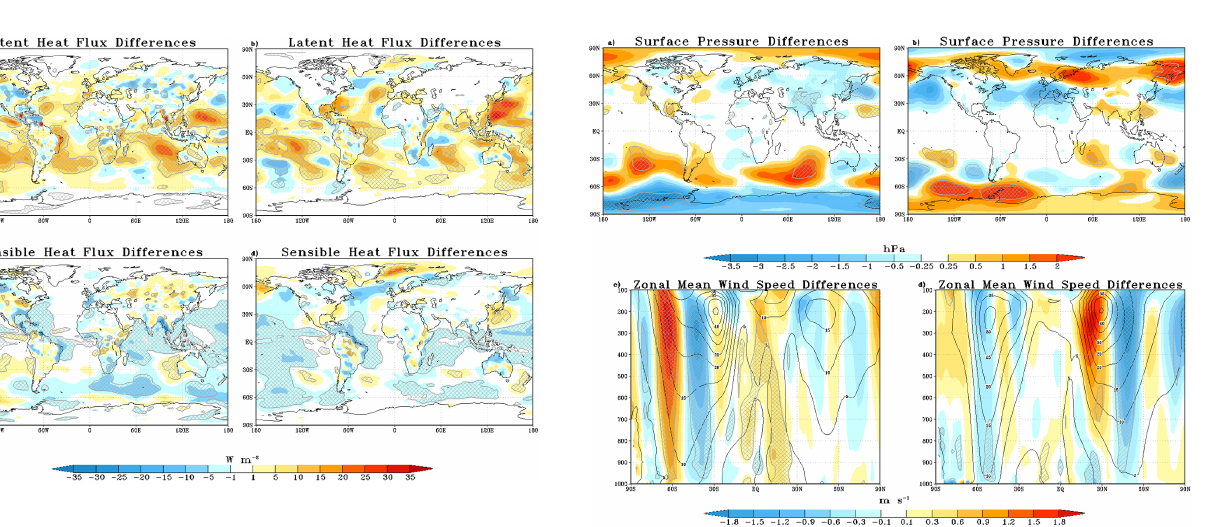
Figure 6. Seasonal mean latent heat flux differences (Method 3 mi- nus Method 2) for JJA (a) and DJF (b) and seasonal mean sensible heat flux differences for JJA (c) and DJF (d) . Hatch marks represent significance at the 90% level using the Student’s t test. Crosshatch marks represent significance at the 95% level.